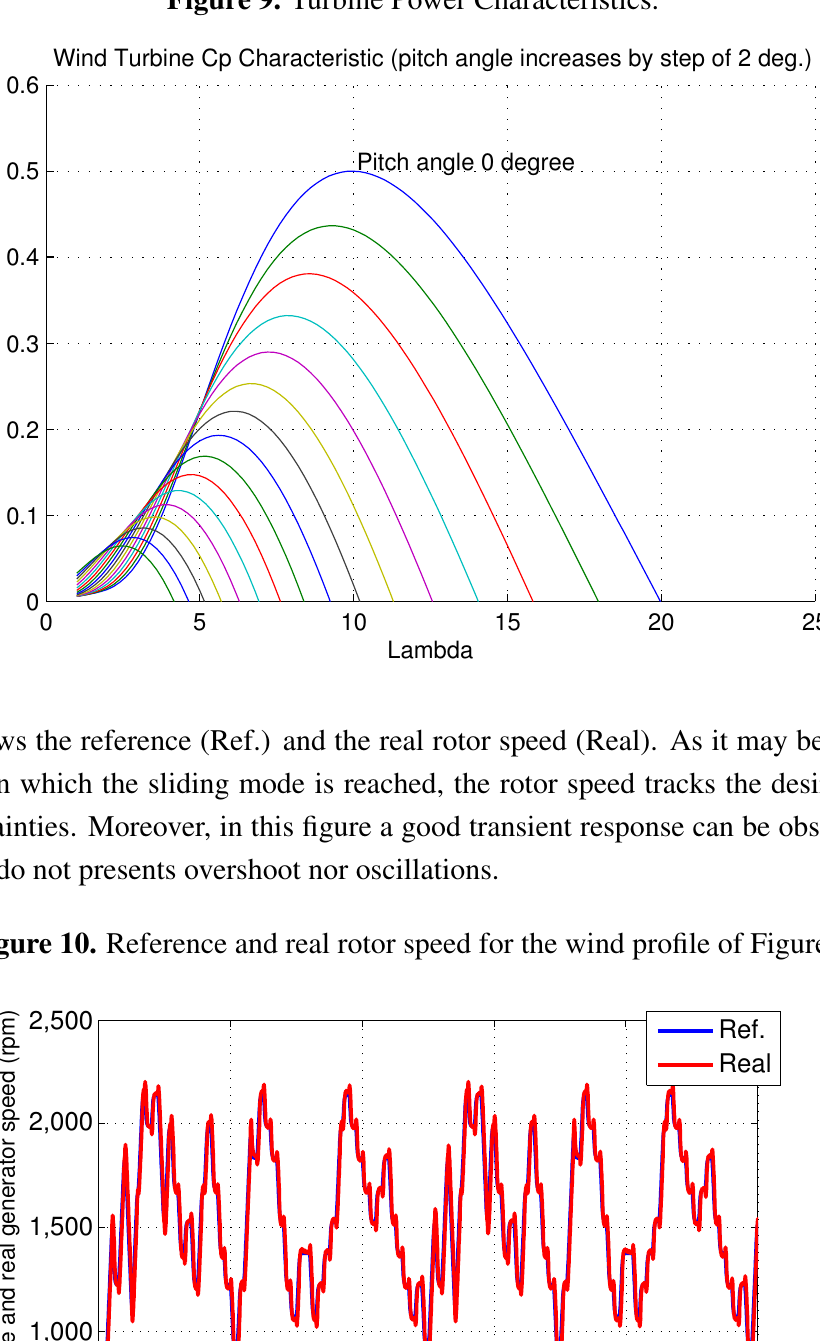
Figure 9. Turbine Power Characteristics.